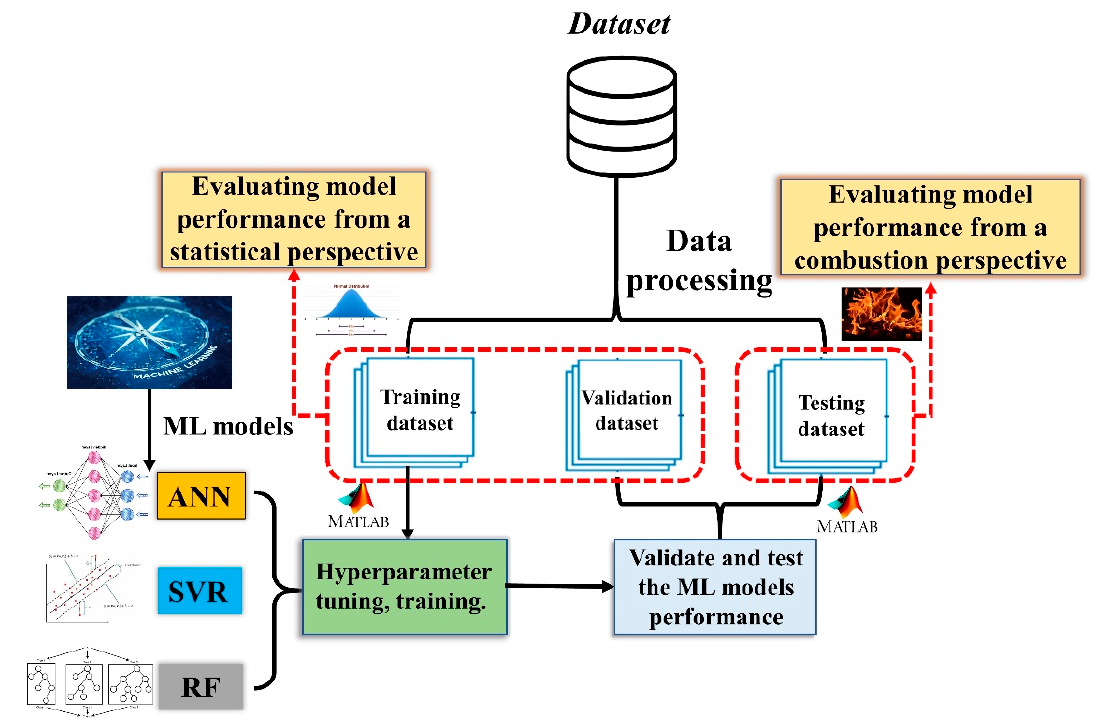
Figure 3. The application process of three ML models for predicting the engine-out parameter.